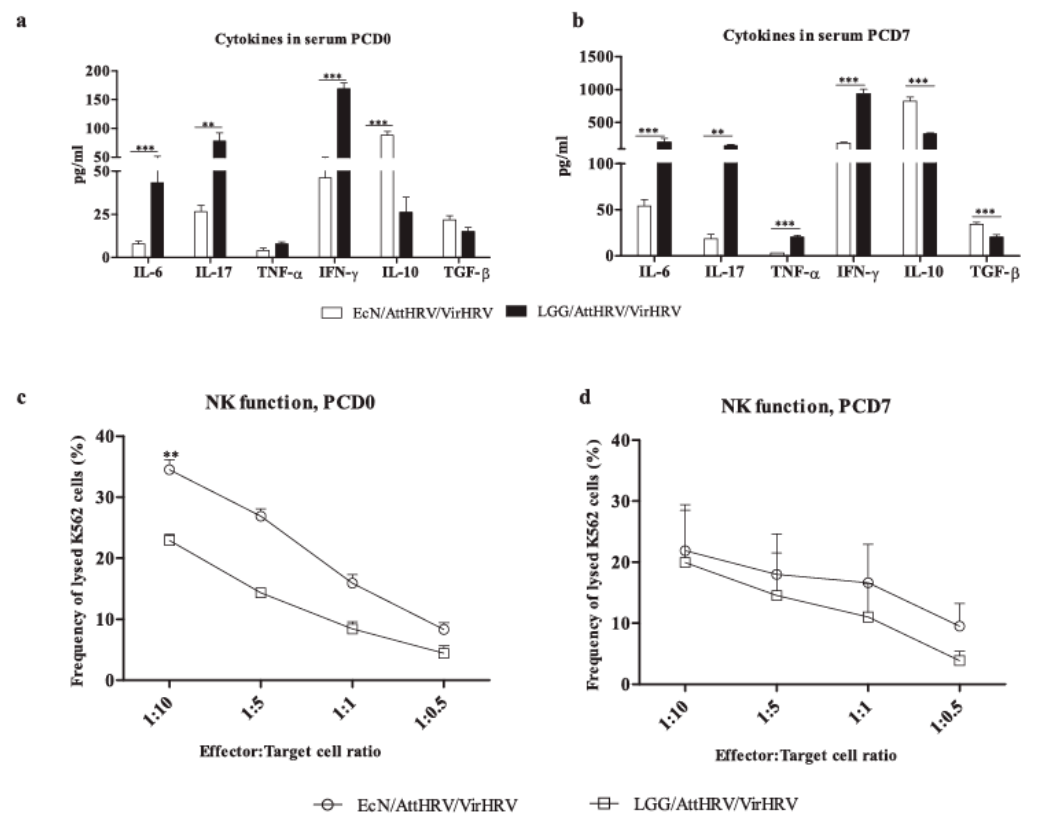
Figure 2. EcN colonization reduced the proinflammatory and increased the immunoregulatory cytokines in serum and modulated the function of natural killer (NK) cells. Mean concentrations of proinflammatory (IL-6, IL-17, TNF- α , IFN- γ ) and T regulatory (IL-10, TGF- β ) cytokines in serum determined at PCD0 ( a ) and PCD7 ( b ) by ELISA assay. NK cell function in blood MNCs ( c , d ). Blood MNCs and carboxyfluorescein diacetate succinimidyl ester (CFSE)-stained K562 tumor cells were used as effector and target cells, respectively, and cocultured at set ratios to assess the NK cytotoxic function. Data are shown as means ± SEM, EcN vs. LGG, and significant differences (** p < 0.01, *** p < 0.001) are indicated as calculated by nonparametric Kruskal–Wallis rank sum test. Gnotobiotic pigs (Gn) were derived with hysterectomy. EcN and LGG inoculum was inoculated at 3 days of age. All pigs were orally vaccinated twice at a 10 day interval with AttHRV at PBCD 3/post first vaccination day, PVD 0 and PBCD 10/PVD 7(0) (post second vaccination day 0, thereafter referred to as PVD7 (0)). At PBCD 17/PVD 14 (7)/post challenge day (PCD) 0, pigs were euthanized to assess vaccine responses pre challenge. The pigs were challenged with VirHRV and euthanized at PBCD 24/PVD 21 (14)/PCD 7. Escherichia coli Nissle 1917, EcN; Lacticaseibacillus rhamnosus GG (LGG); post bacterial colonization day, PBCD; live oral attenuated human rotavirus vaccine, AttHRV; virulent human rotavirus,